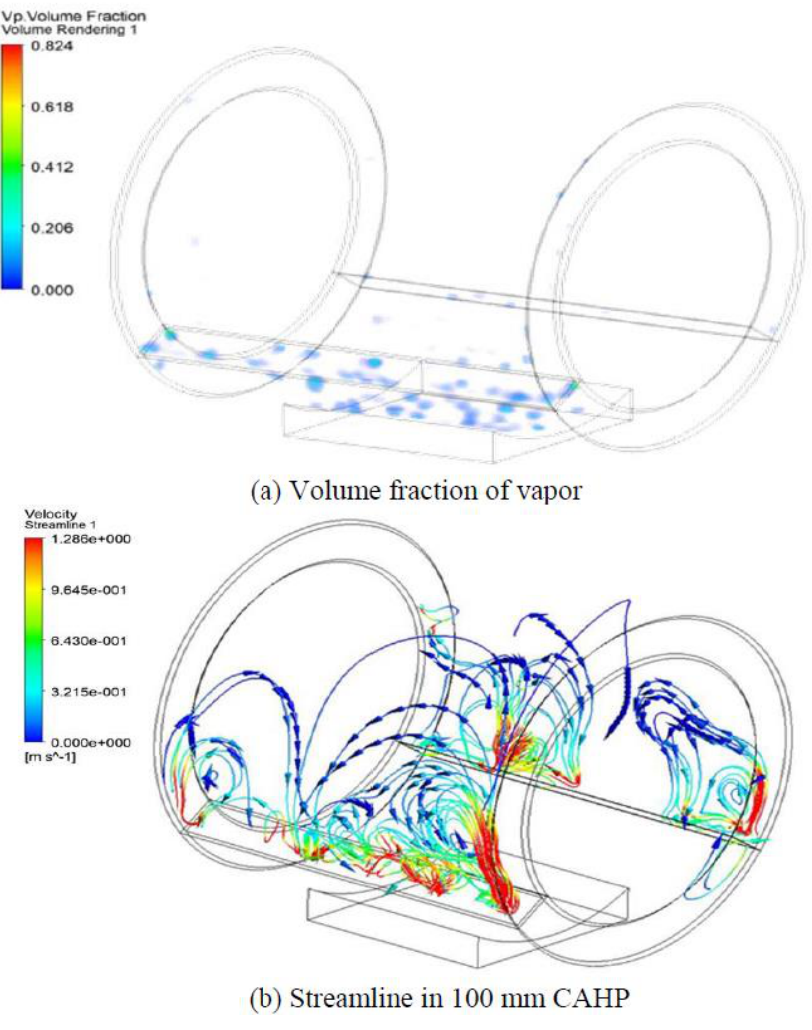
Figure 17. 3D Simulation: Volume fraction contour and streamline; D + = 1.3, L = 100 mm, Model ‘B’, CAHP.